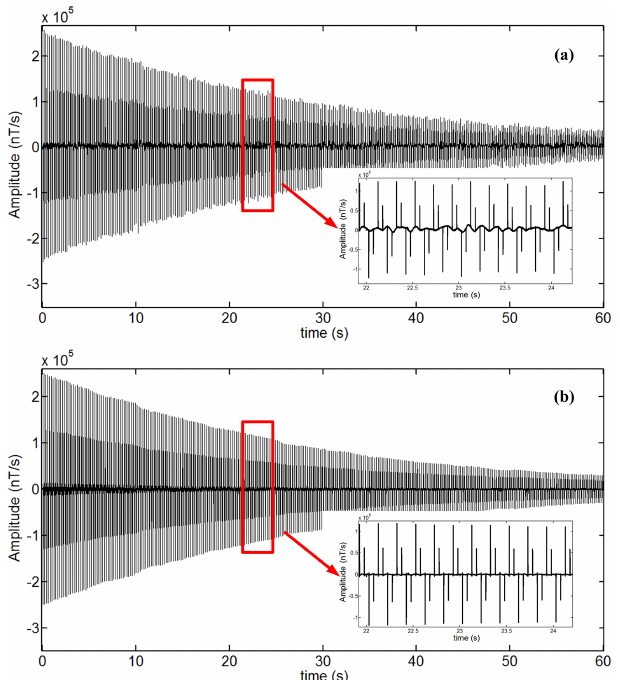
Figure 6. The field data whose duration is 60s containing base- line wander and correctional data filtered by the EEMD-AF method. (a) The field data measured by receiver instruments; (b) the correc- tional data using the EEMD-AF method. The data of 22 to 24s are magnified and shown at the lower right of each panel.